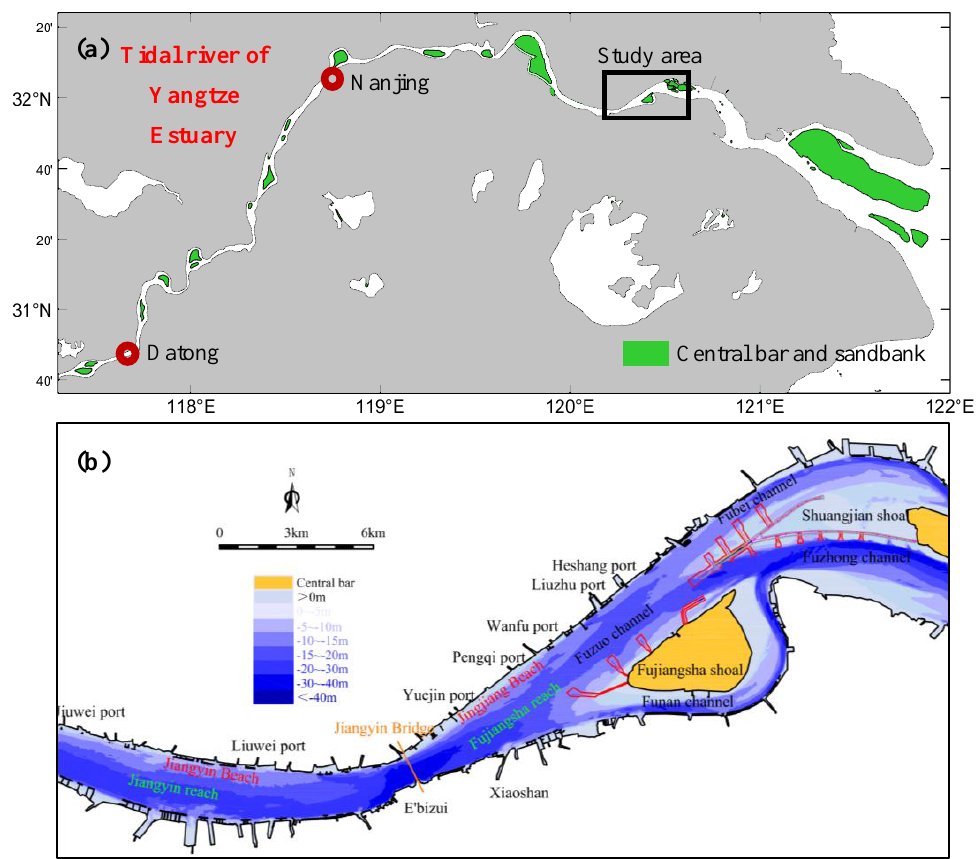
Figure 1. ( a ) Tidal river of Yangtze Estuary; ( b ) river regime of the study area.